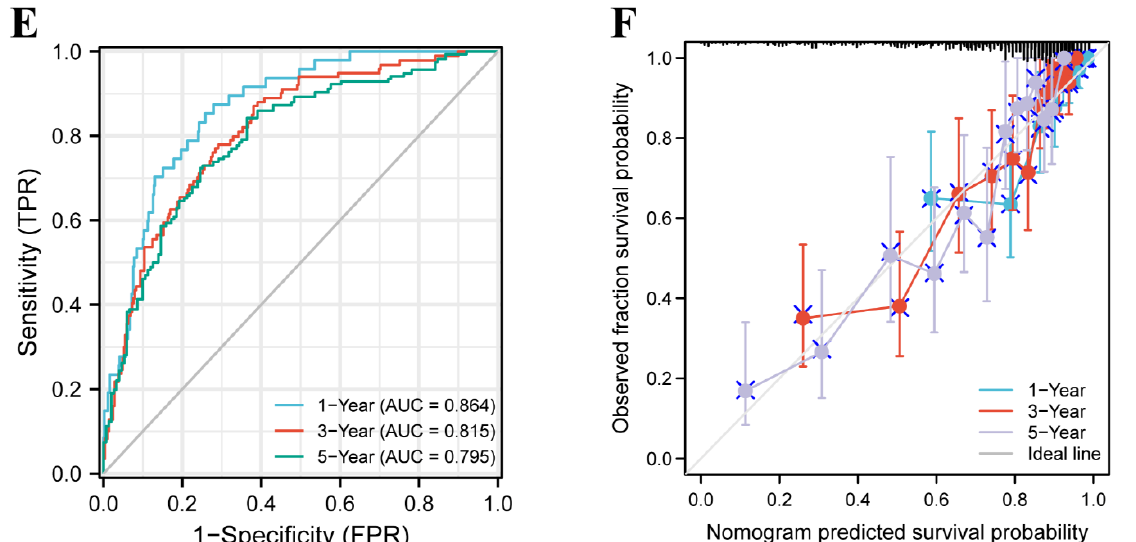
Figure 4. FPM could be an independent prognostic factor for ccRCC. ( A ) Heatmap showing the correlations between risk groups and clinical characteristics. ( B ) Univariate Cox regression analysis of the factors. ( C ) Multivariate Cox regression analysis of the factors. ( D ) A prognostic nomogram model for predicting 1-, 3-, and 5-year survival probability. ( E ) Time-dependent ROC curves of the nomogram. ( F ) Calibration curves of the nomogram for predicting 1-, 3-, and 5-year survival